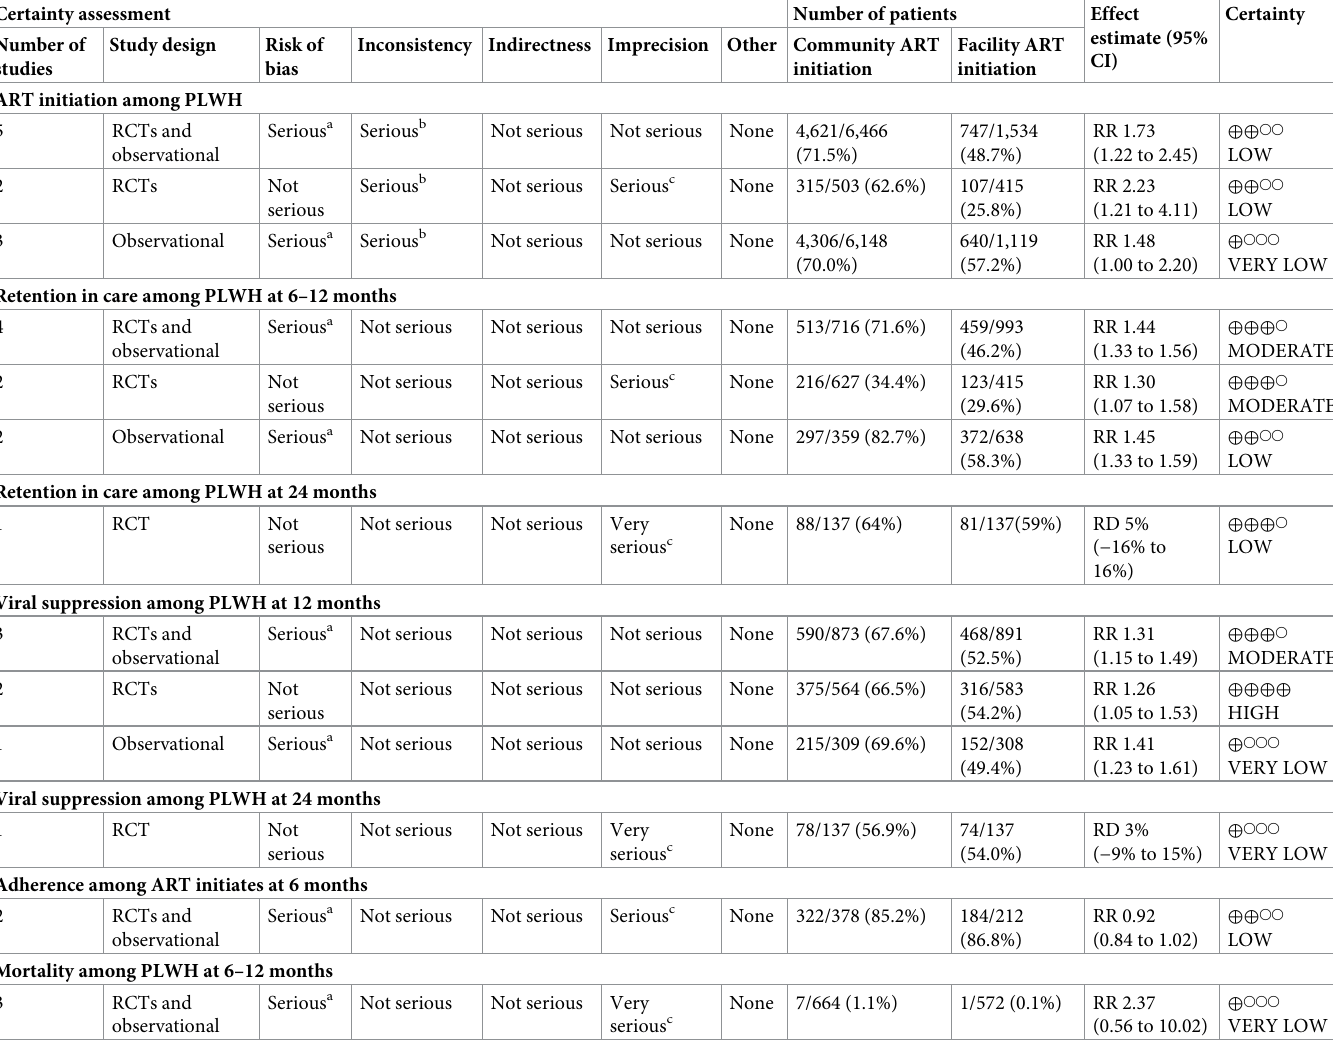
Table 7. Review evidence certainty assessment (GRADE): Community ART initiation versus facility ART